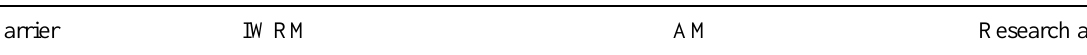
Barrier IWRM AM Institu